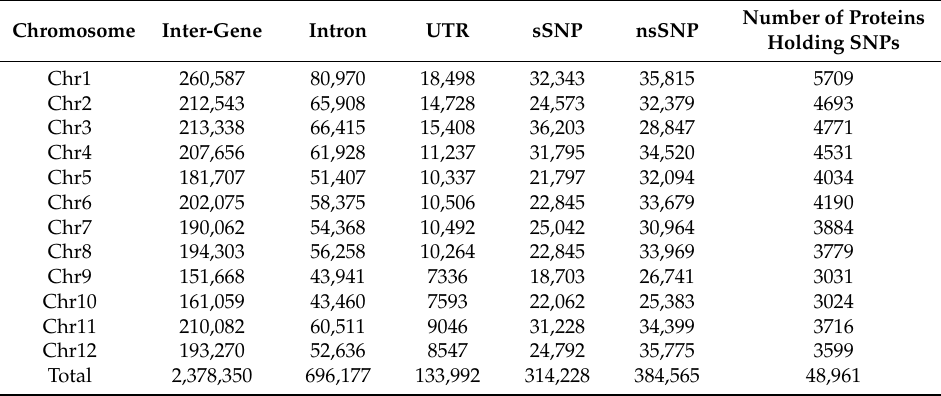
Table 1. Different SNPs on different chromosomes in rice genome